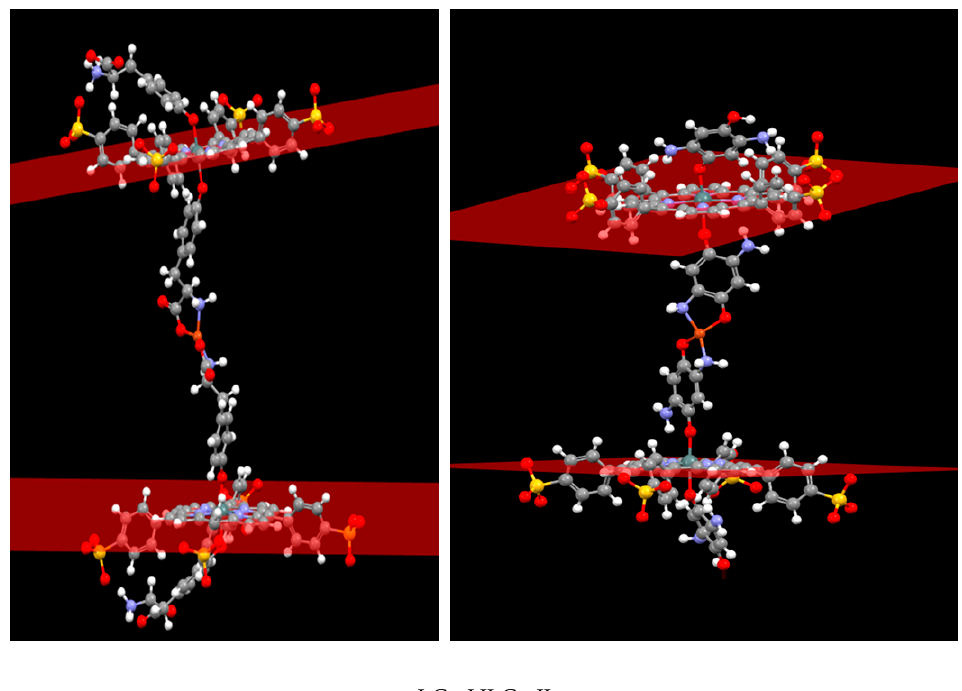
Figure 3. Structures of the dimers I-Cu-I and II-Cu-II optimized by the DFT/CAM-B3LYP hybrid functional and 3–21g basis.